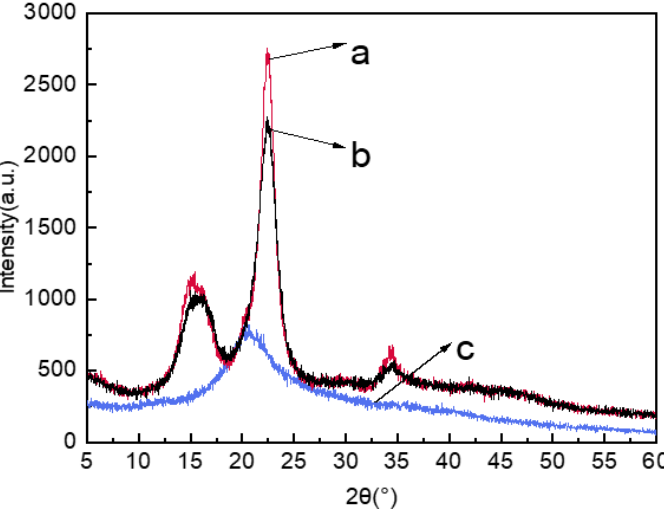
Figure 3. XRD images of standard MCC (a), jute MCC (b), and jute MCC membrane (c).